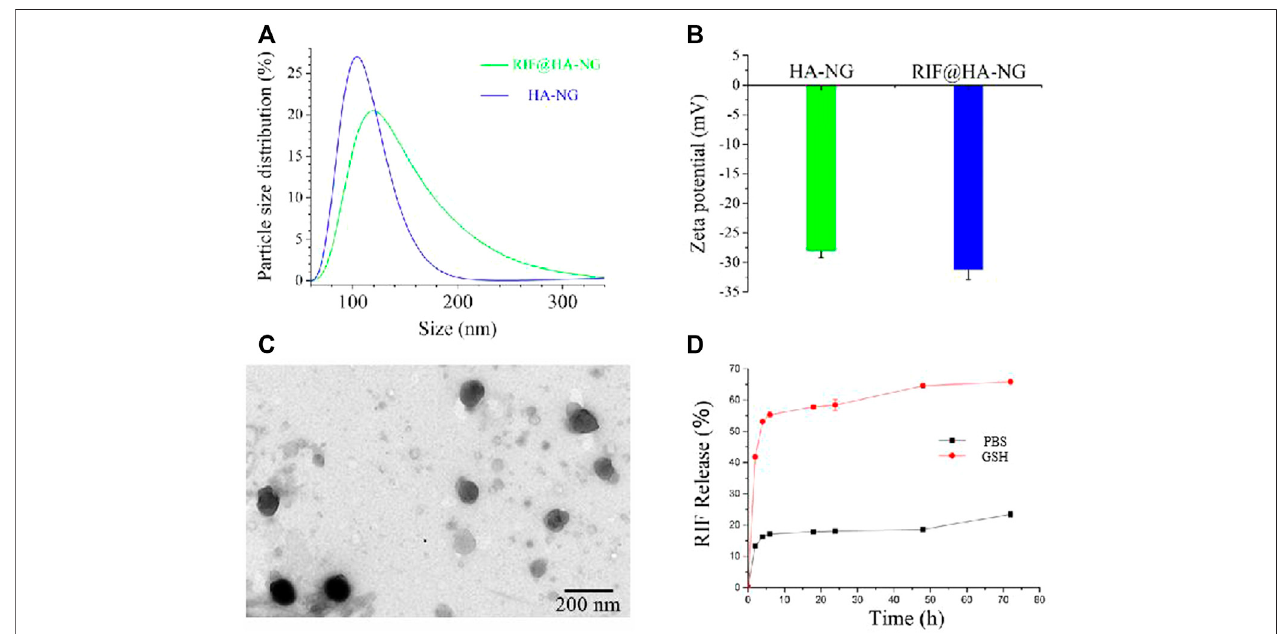
FIGURE1 | Characterizations ofthe RIF@HA-NG. (A) The dynamic lightscattering (DLS) analysis ofHA-NG and RIF@HA-NG. (B) The zetapotentialresults ofHA- NG and RIF@HA-NG. (C) The transmission electron microscopy (TEM) images of RIF@HA-NG, scale bars are 200 nm. (D) The RIF release of RIF@HA-NG (PBS) in the absence or presence of GSH.